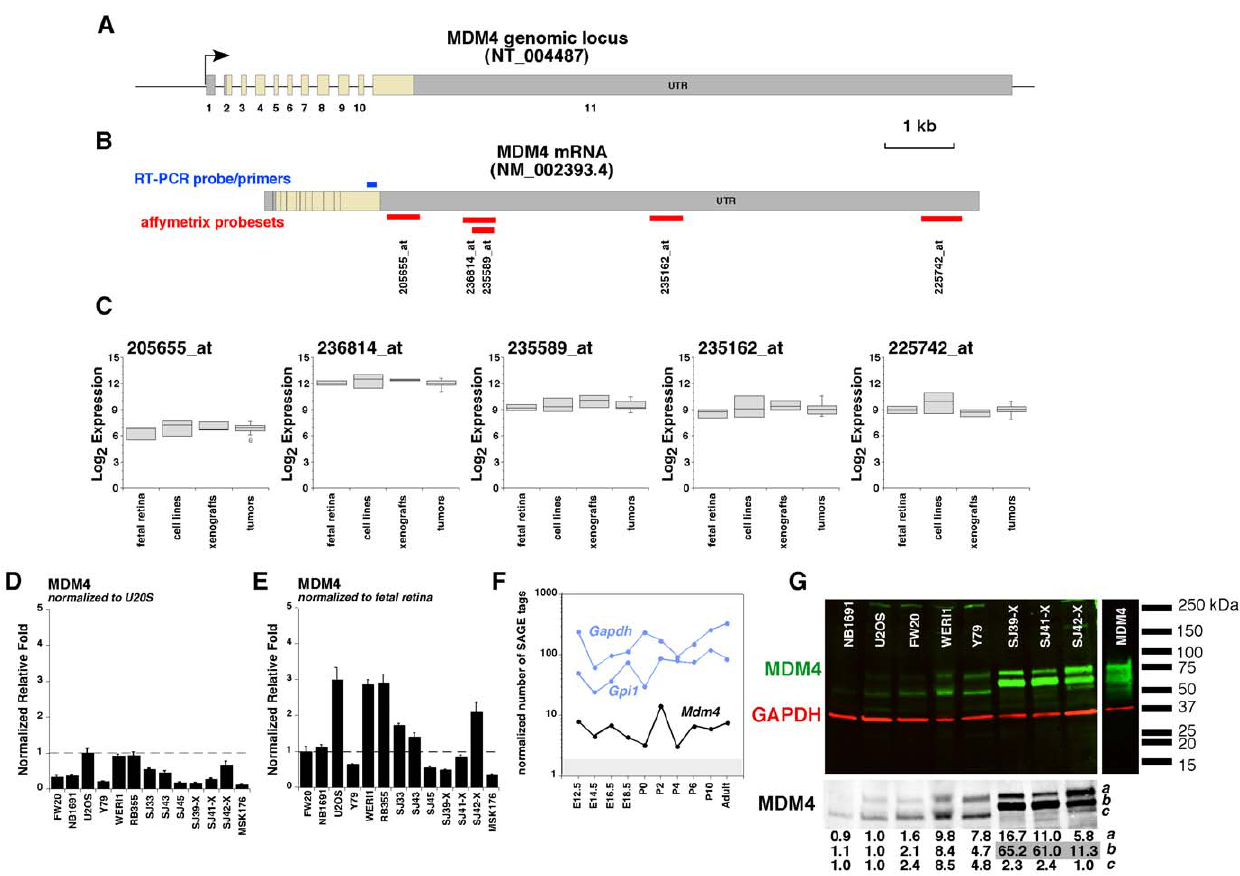
Figure 2. Expression of MDM4 in retinoblastoma. A ) Structure of the genomic organization of the 11 exons of human MDM4 . The exons are to scale as shown but the introns are not to scale. ( B ) Schematic of the spliced MDM4 mRNA that produces the full-length MDM4 protein. The location and identification of Affymetrix gene expression array probesets are shown in red and the location of the real time RT-PCR probe/primer set is shown in blue. ( C ) Boxplots of the Log 2 expression of each of the 5 probesets that uniquely mapped to MDM4 for fetal retina, cell lines, xenografts and 52 primary human retinoblastomas. ( D ) Real time RT-PCR for MDM2 using Taqman probes as shown in (B) for fetal retina at gestational stage week 20 (FW20), control cell lines (NB1691 and U20S), retinoblastoma cell lines (Y79, Weri1, RB355), primary tumors (SJ33, SJ43, SJ45), and retinoblastoma xenografts (SJ39-X, SJ41-X, SJ42-X and MSK176). Values were normalized to the positive control (U2OS). ( E ) The same data as shown in (D) but normalized to fetal retina. Each bar is the mean and standard deviation of duplicate experiments. ( F ) The SAGE data from developing mouse retina shows Mdm4 is expressed at significant levels in the developing mouse retina. The gray shaded box represents the limit of detection by SAGE ( , 2 normalized tags per sample). Gapdh and Gpi1 are plotted as ubiquitiously expressed internal controls. ( G ) Immunoblot of MDM4 (green) protein in a subset of the samples analyzed by real time RT-PCR. Gapdh (red) was used as an internal reference for gel loading and the normalized values are presented below the black and white presentation of the blot for MDM4. The antibody was verified for specificity using a blocking peptide (not shown). Recombinant full length Flag-MDM4 protein was included as a positive control. Multiple bands were detected for MDM4 and were quantitated (below the black and white picture of the blot) and normalized to GAPDH and relative to U2OS cell